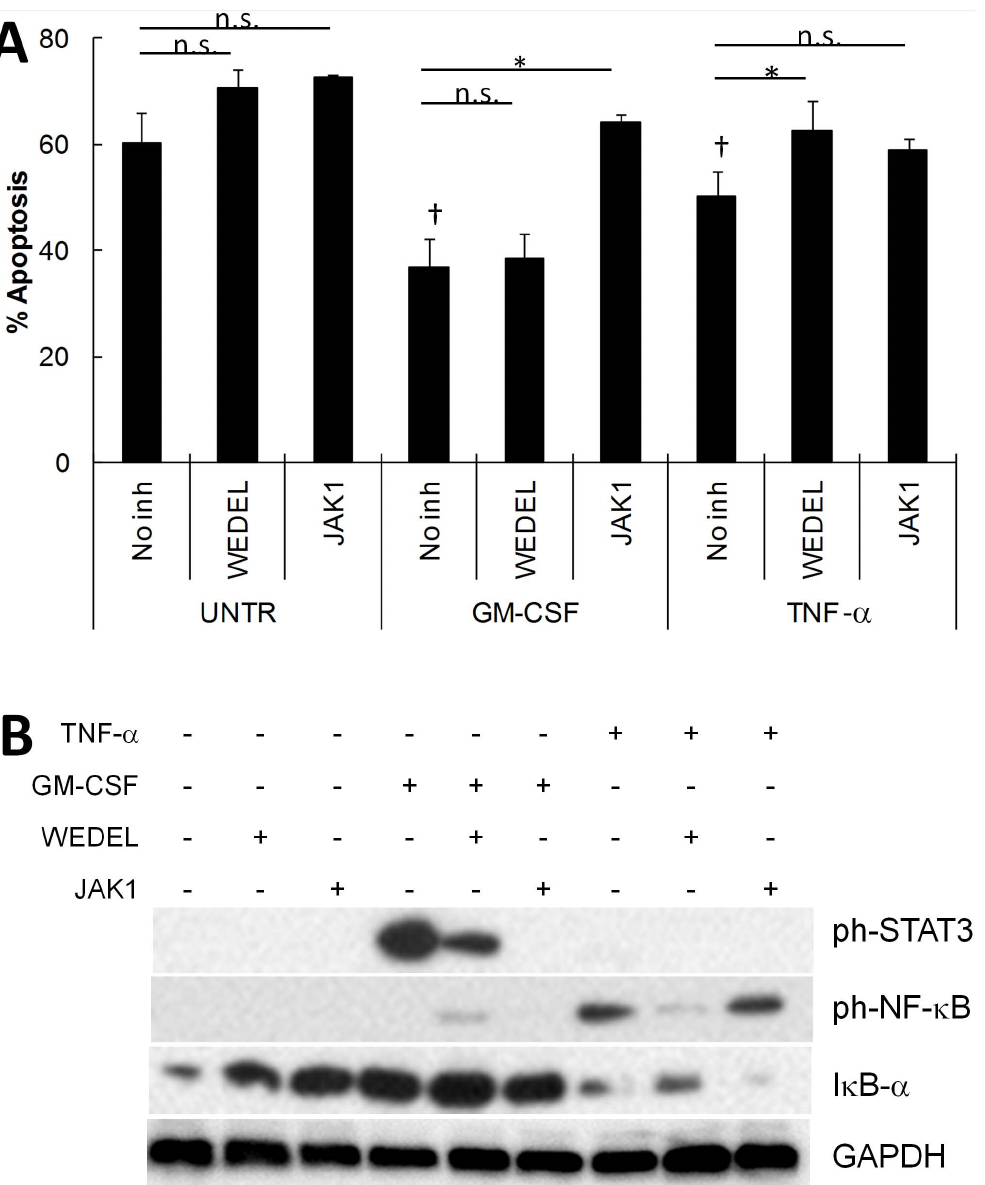
apoptosis seen in untreated (UNTR) neutrophils. Inhibition of STAT signalling with JAK inhibitor-1 (JAK1, 10 m M) abrogated the effect of GM-CSF on neutrophil apoptosis (*p , 0.05) but did not affect TNF-delayed apoptosis. Inhibition of NF- k B with wedelolactone (WEDEL, 50 m M) abrogated the effect of TNF- a , but not GM-CSF, on neutrophil apoptosis (*p , 0.05). (B) Western blot of NF- k B and STAT3 activation in TNF- a and GM-CSF treated neutrophils. TNF- a induced rapid phosphorylation of NF- k B (p65) and degradation of I k B- a , which was inhibited by wedelolactone. GM-CSF did not induce phosphorylation of NF- k B or degradation of I k B- a , but did induce STAT-3 phosphorylation which was inhibited by JAK inhibitor-1. TNF- a did not activate STAT-3 in